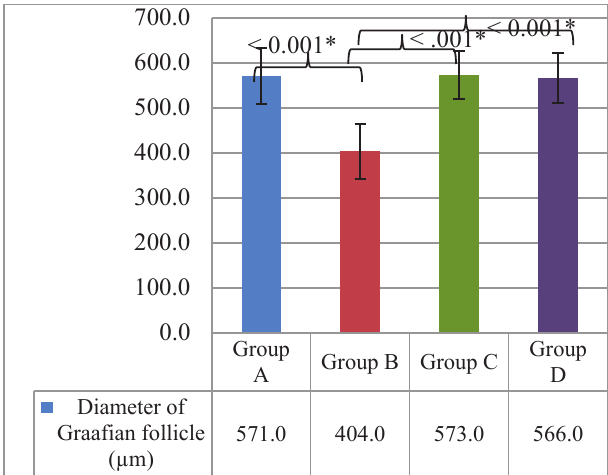
Fig-5: Bar chart showing comparison of diameter of Graafian follicle (μm) among